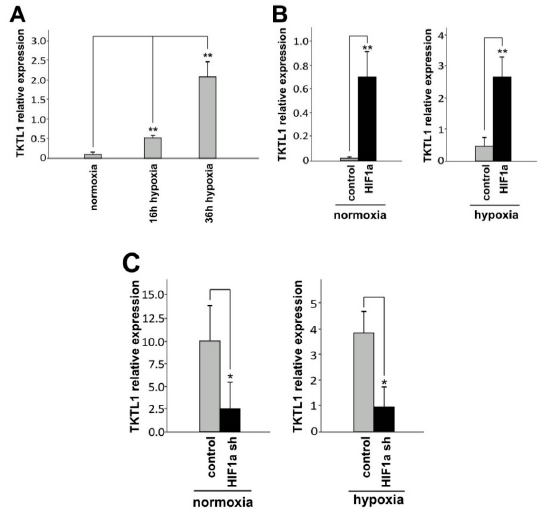
Figure 1. Hypoxia and HIF-1 α upregulate TKTL1 expression. ( A ) LNT-229 cells were grown at normoxia for 36 h and at hypoxia for 16 h and 36 h, respectively, and TKTL1 expression was analyzed by RT-qPCR (mean + SD, ** p < 0.01); ( B ) LNT-229 cells were transiently transfected with pcDNA3-HIF-1 α or pcDNA3 control and 24 h later subjected to different oxygen concentrations. Another 24 h later, TKTL1 was assessed by RT-qPCR (mean + SD, ** p < 0.01); ( C ) similarly, LNT-229 cells stably expressing shRNA targeting HIF-1 α or its Drosophila homolog Sima (control) were grown in normoxia and hypoxia and 24 h later analyzed for TKTL1 mRNA levels (mean + SD, * p <